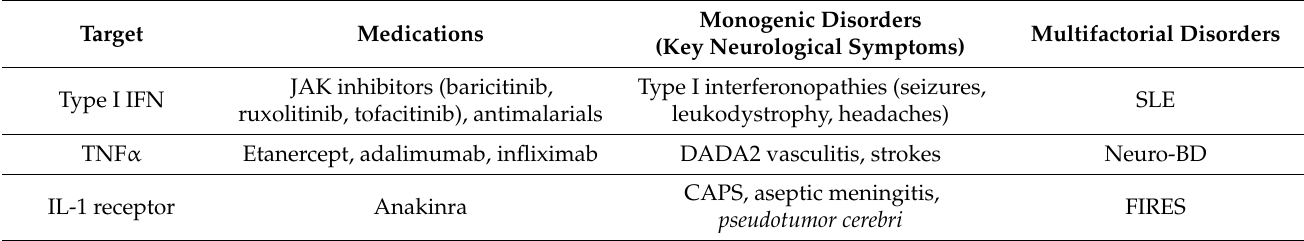
Table 1. Medications for immune-mediated brain